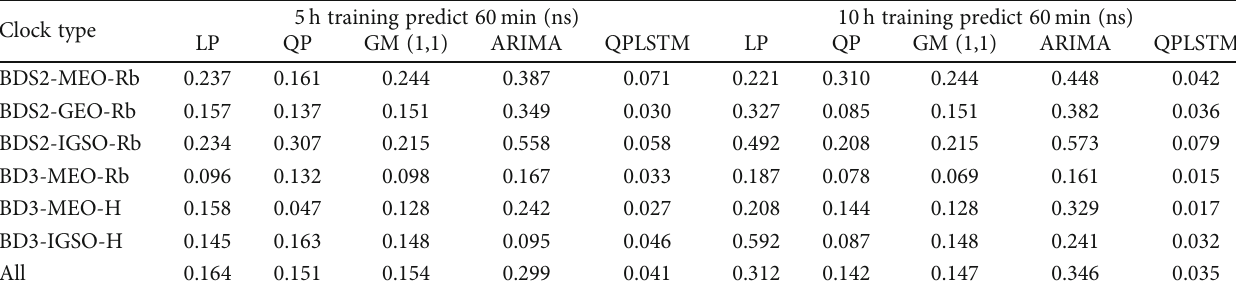
Table 8: 60min average prediction MAE for six di ff erent clock categories based on the fi ve models using 5 h or 10h prior data. Clock